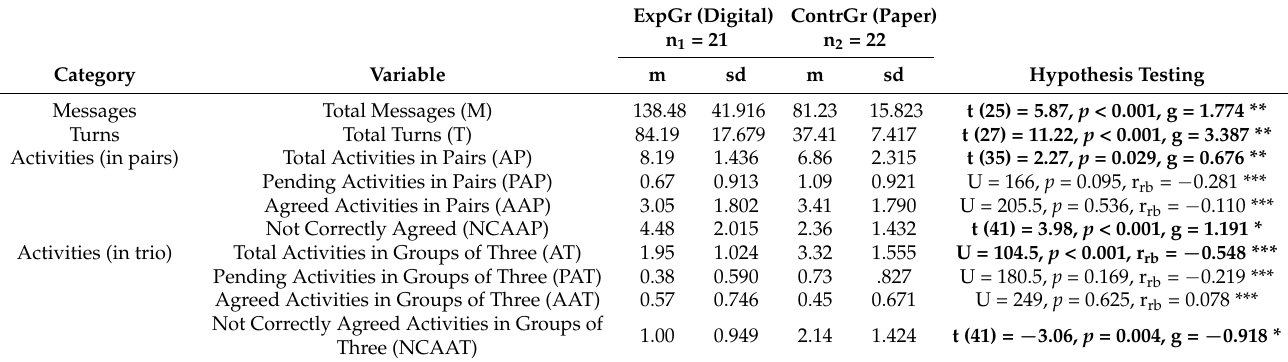
Table 2. Descriptive statistics and hypothesis testing results in order to answer RQ2.